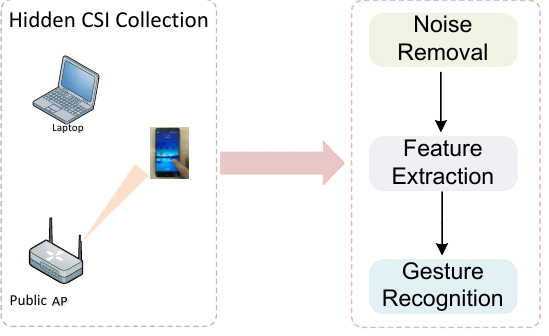
Figure 2. The process of CSI-based attack. After obtaining CSI measurements at the receiver end, the attacker needs to remove the noise, extract the features from the noise-removed signals and finally recognize the input sensitive information using machine learning